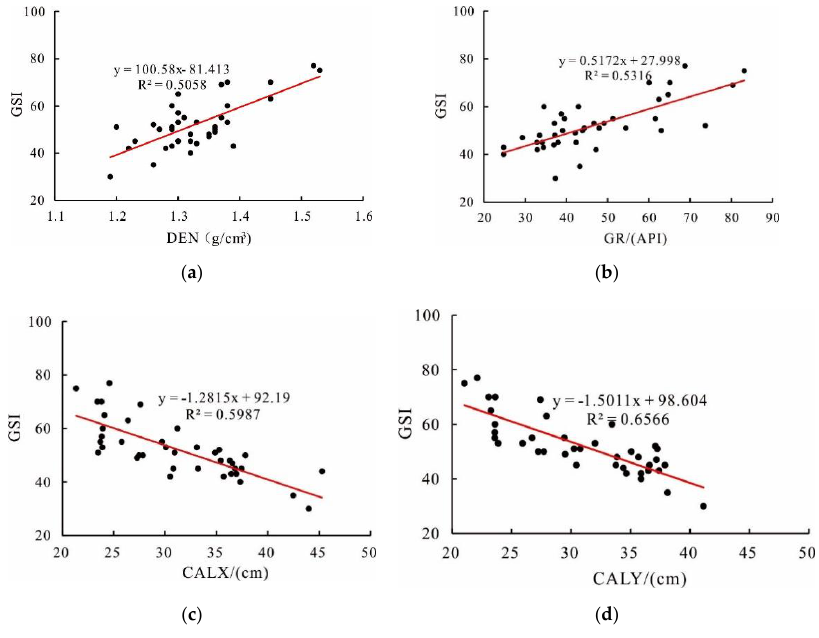
Figure 4. ( a ) The relationship between bulk density and GSI. ( b ) The relationship between natural gamma ray and GSI. ( c ) The relationship between borehole diameter of the X direction and GSI. ( d ) The relationship between borehole diameter of the Y direction and GSI.